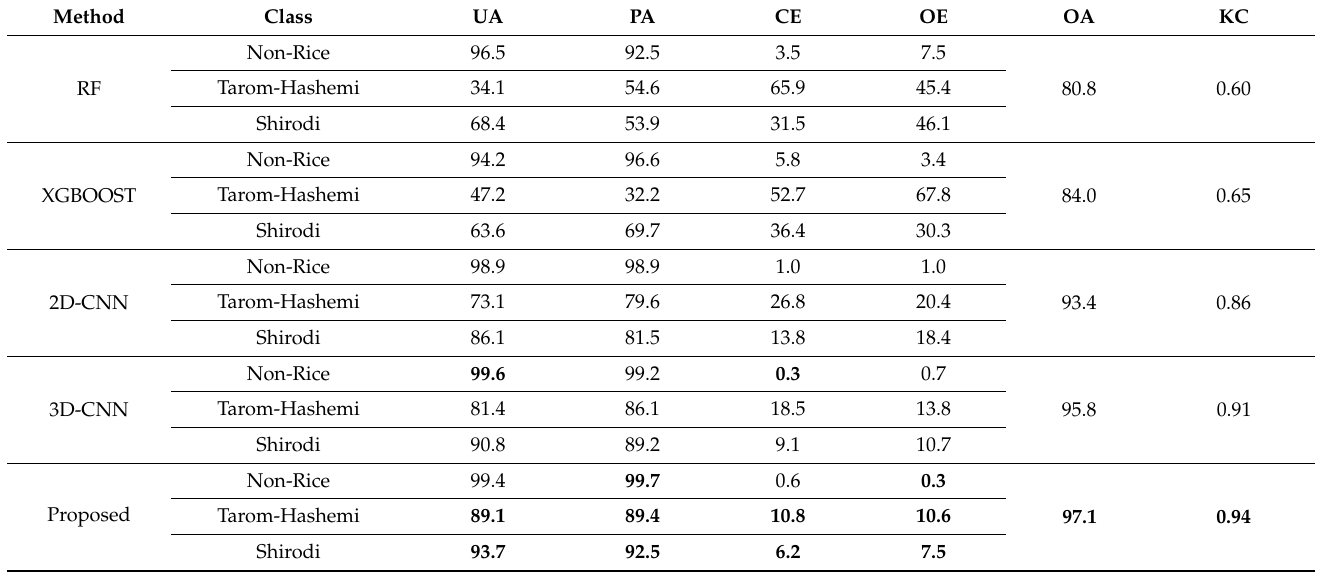
Table 3. Comparison of different classification algorithm accuracies. The bold values show the highest accuracies.